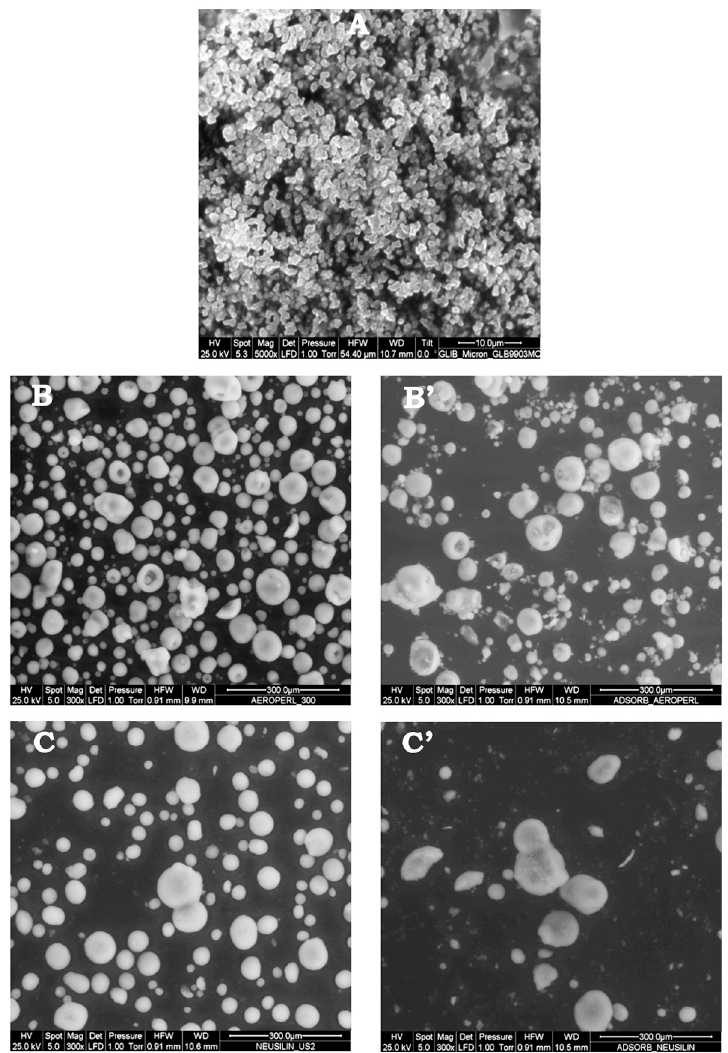
Figure 5. ESEM images of pure glyburide ( A ), Aeroperl ® 300 ( B ) and Neusilin ® US2 ( C ) and of the corresponding liquisolid systems ( B’ and C’ ).